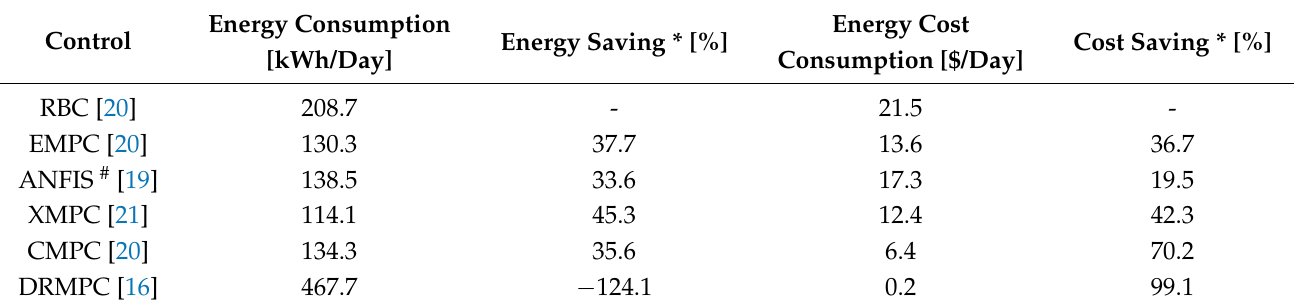
* Percentages are calculated by comparing with the baseline RBC. # Computational time of the ANFIS controller reduces by 90% in comparison with the